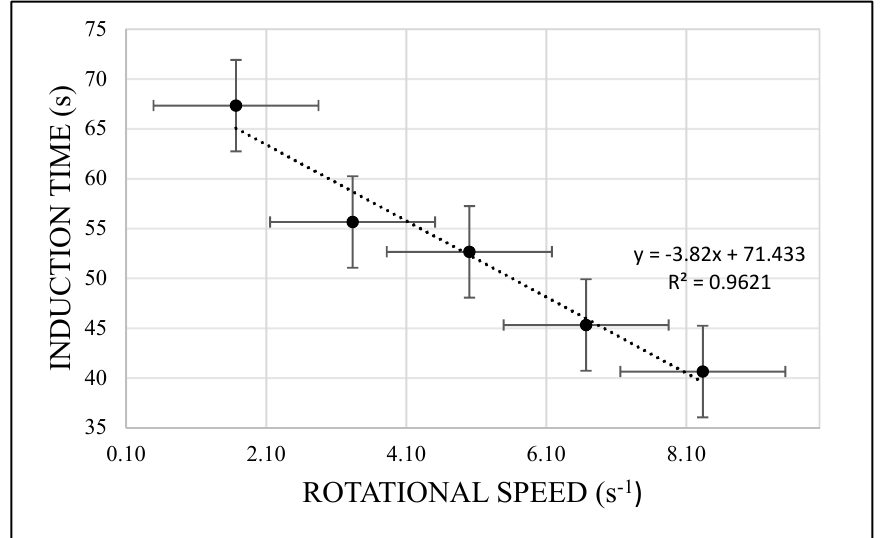
Figure 7. Induction time versus rotational speed.